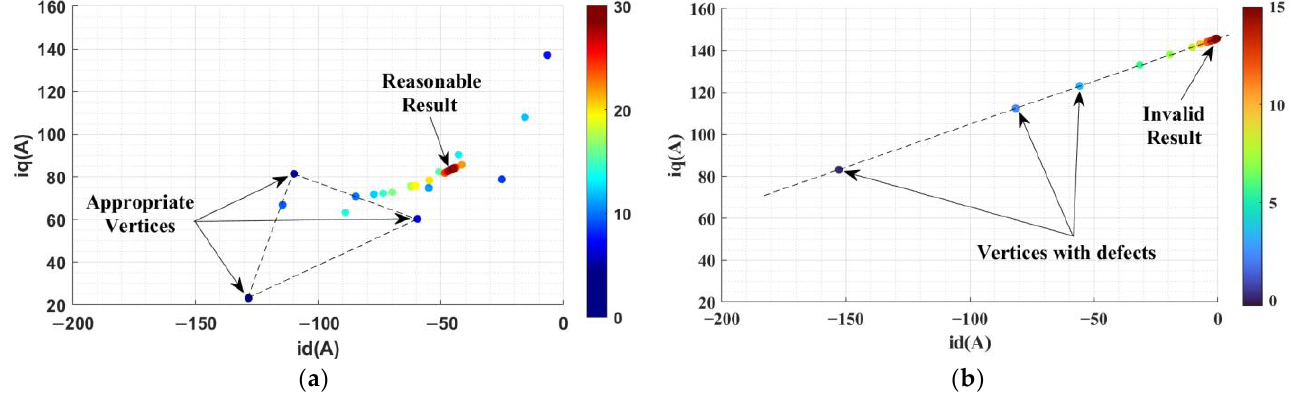
Figure 11. Direct search and degradation of the basic NMS method: ( a ) effective iterative process; ( b ) iterative process of failure.